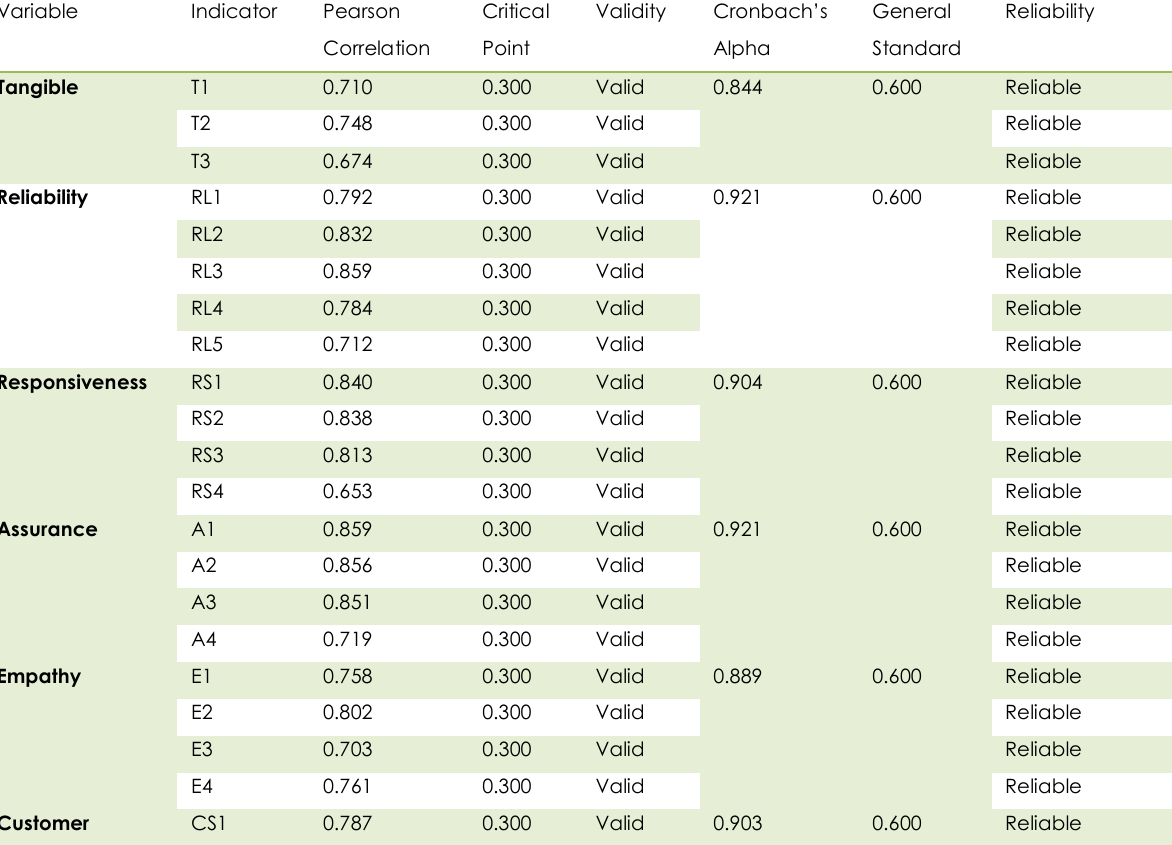
Table 2 Pilot Test